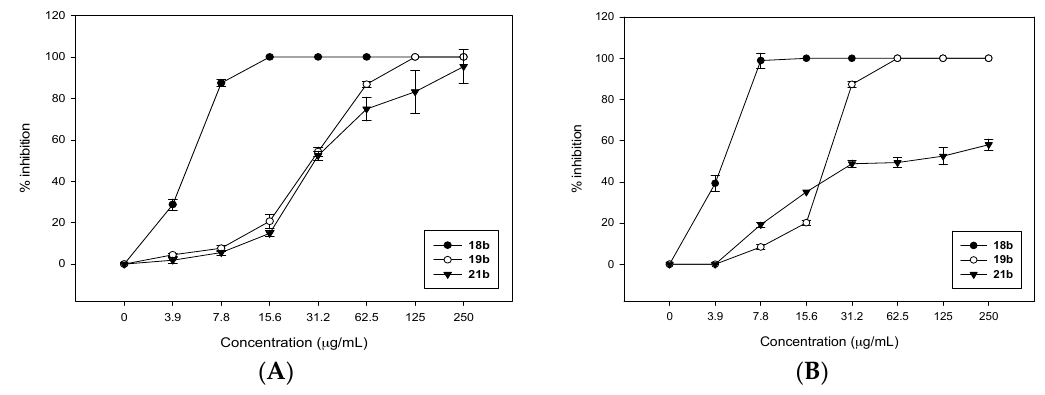
Figure 5. Comparative antifungal activities of compounds 18b , 19b , 21b possessing the same R 1 substituent but differing in their functional groups (i.e., 18b is a β -ketoamine; 19b a γ -aminoalcohol and 21b an allylamine). ( A ) against C. albicans ; ( B ) against C. neoformans . Amphotericin B (Amp B) inhibits 100% growth at 1.0 µg/mL against C. albicans and at 0.5 µg/mL against C. neoformans . Curves of Amp B are not included.